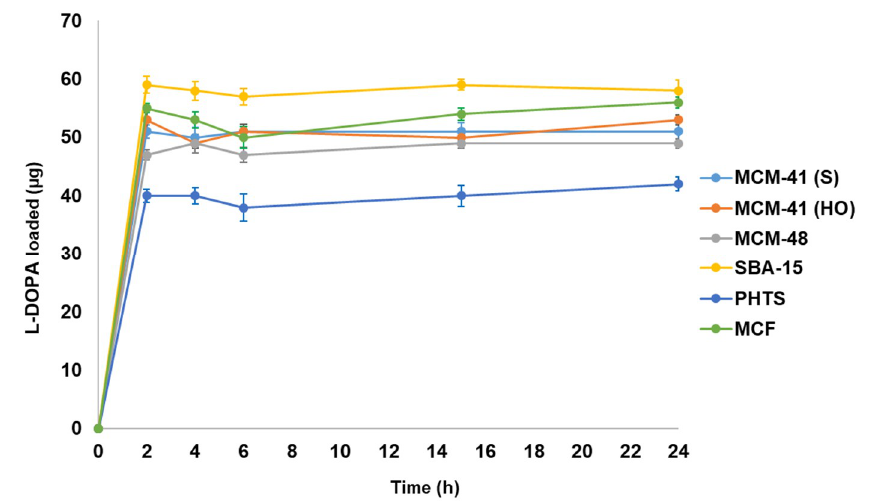
Figure 8. The L-DOPA loading profiles for all six types of mesoporous silica particles.